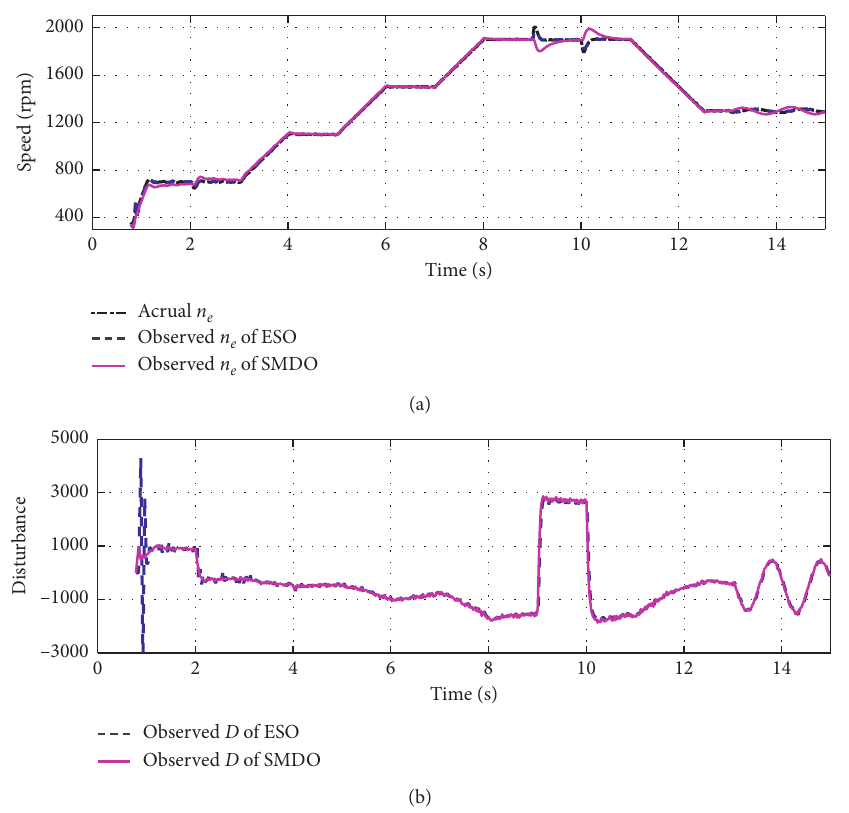
Figure 6: The observation performance comparison between the ESO and SMDO.